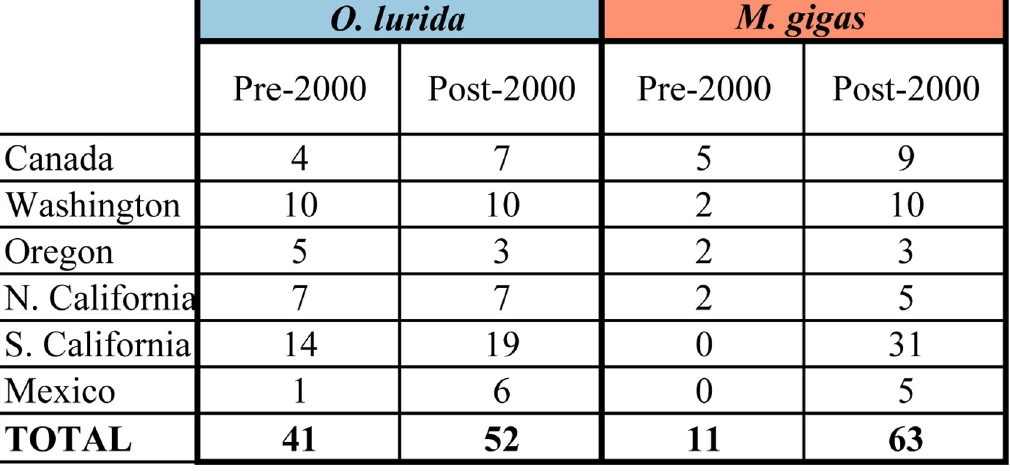
Fig 6. Number of estuaries with oysters present by species, pre-2000 vs. post-2000.